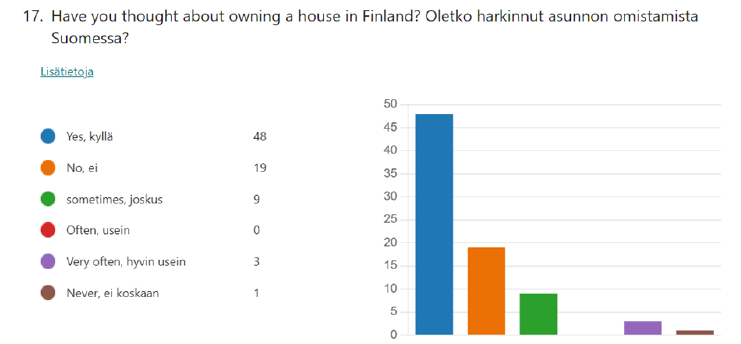
Figure 5. 75% of the respondents have considered owning a dwelling in Finland. Source: (Authors’ elaboration).